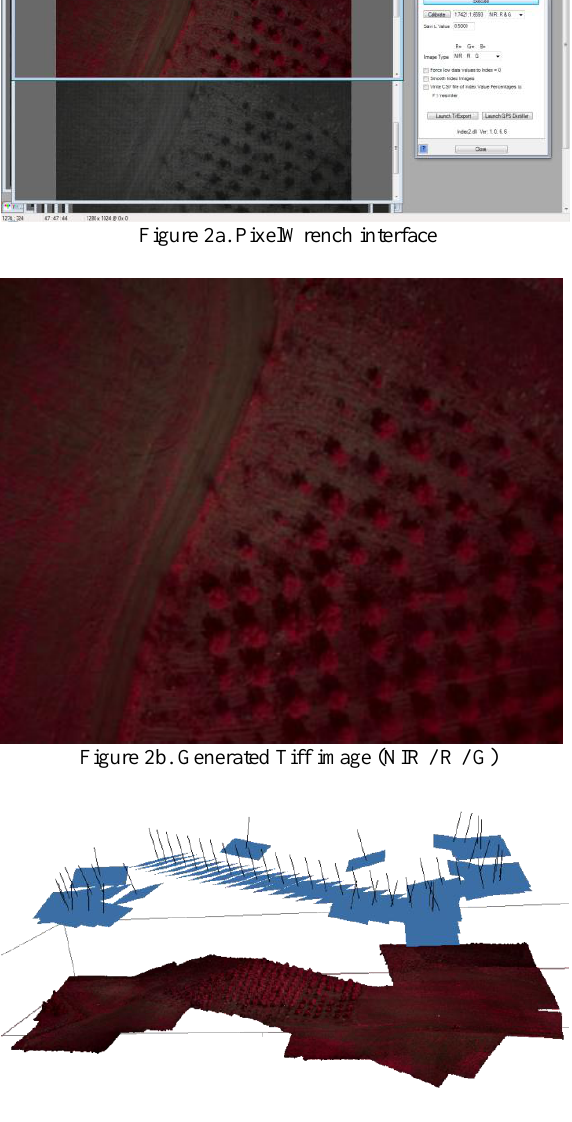
Figure 3. The creation of the photo line with the PhotoScan and the dense of point cloud